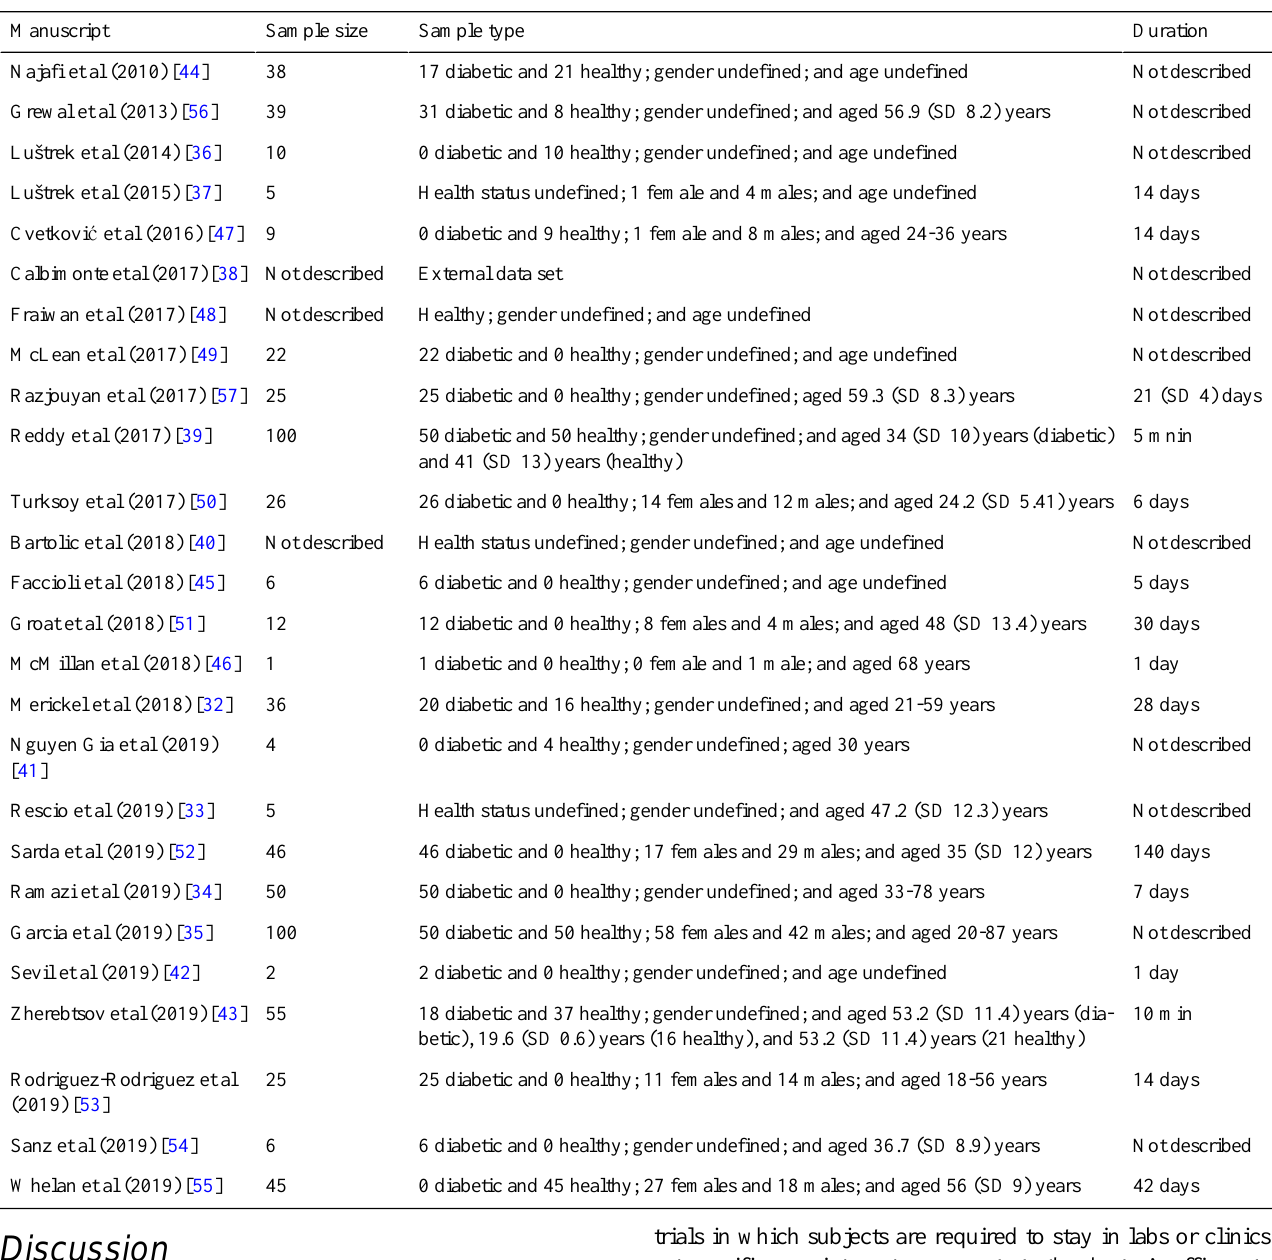
Table 4. Summary of study topic ordered by the year of publication.